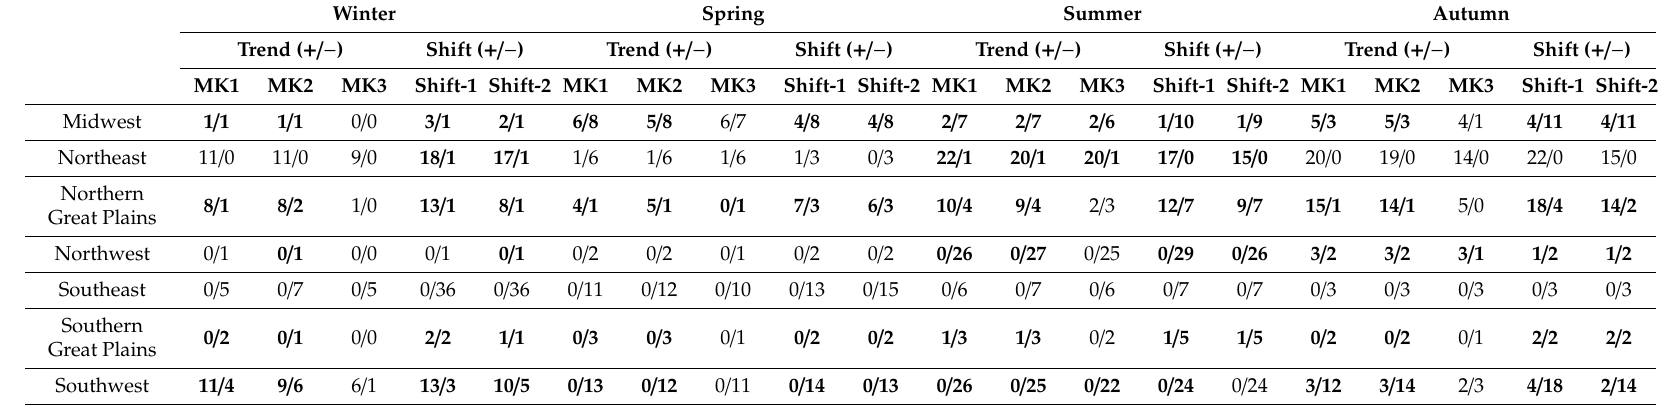
Table 2. Results for the Mann–Kendall (MK) test along with Pettitt Shift before / after accounting lag-1 autocorrelation (Shift-1 / Shift-2) for seasonal streamflow. The entries in bold identify the region was field significant at p ≤